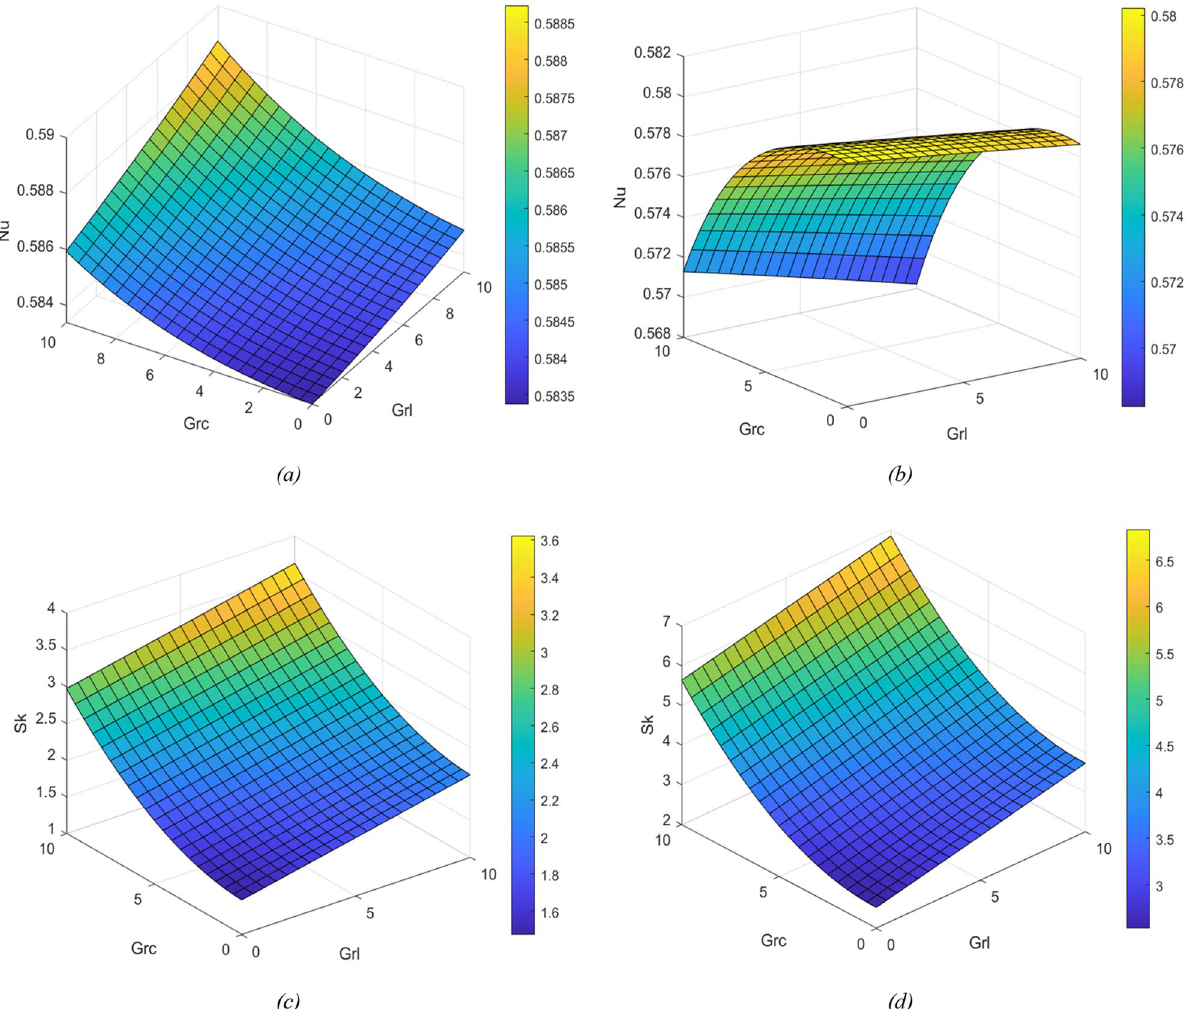
Figure 8. Nusselt graphs for change in GrL and GrC ( a ) at the left plate (y = − 1) ( b ) at the right plate (y = 1). Skin friction for change in GrL and GrC ( c ) at the left plate (y = − 1) ( d ) at the right plate (y =